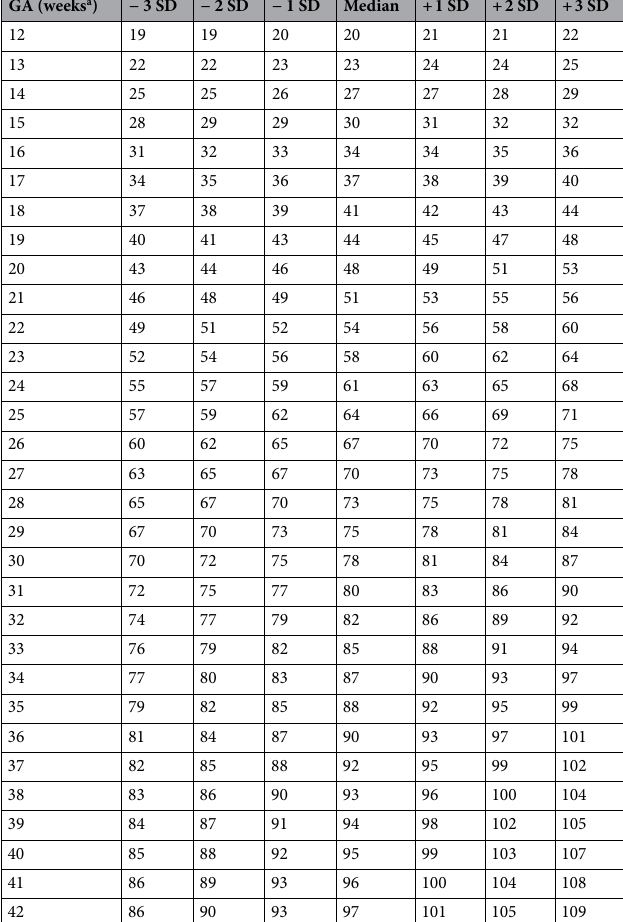
Table 2. Estimated biparietal diameter (BPD) in mm by gestational age (GA) for males and females, standard deviations (SD). a GA expressed as completed gestational weeks, e.g. 12 weeks corresponds to 12 + 0 weeks or 84 gestational